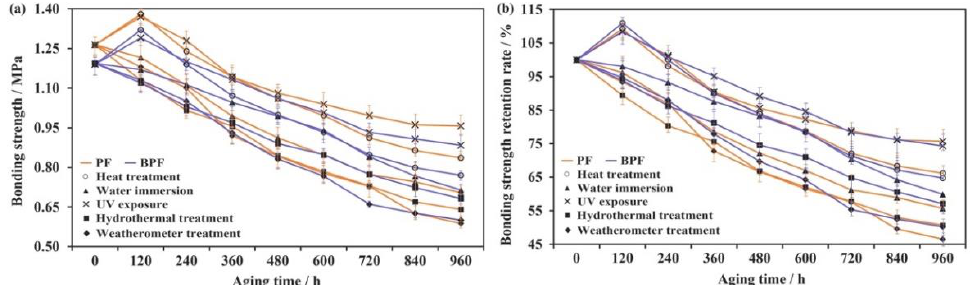
Figure 2. Variation in the bonding strength ( a ) and its retention rate ( b ) of BPF and PF resin plywood under five aging conditions. under five aging